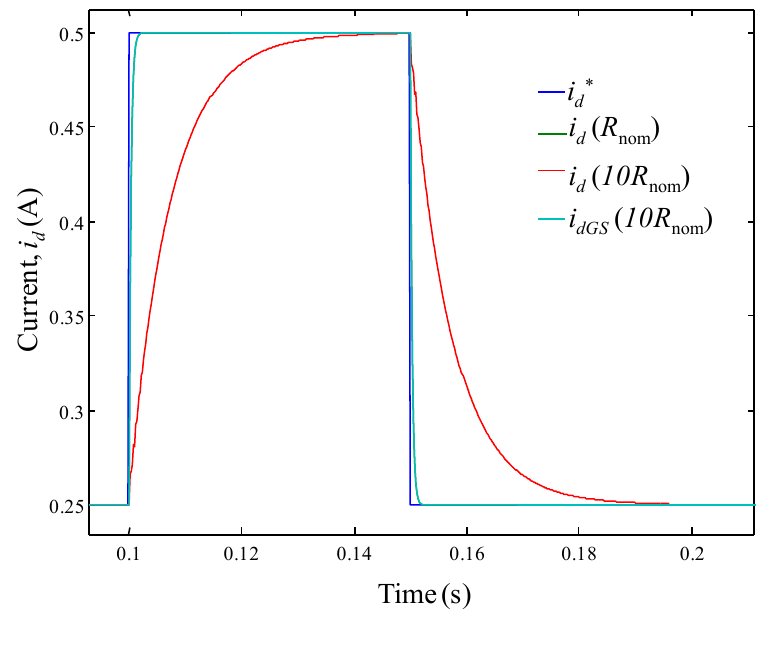
Figure 12. Temporal response of i when the current reference changes in t = 0.1 s from d 0.25 to 0.5 A, and in t = 0.15 s from 0.5 to 0.25 A for both controllers in two different operating points, R = R and R = 10 R nom nom .